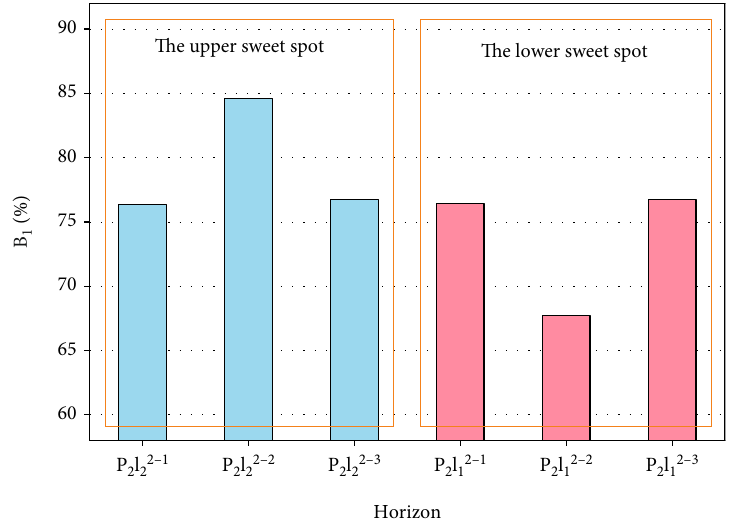
Figure 4: The brittleness distribution in di ff erent